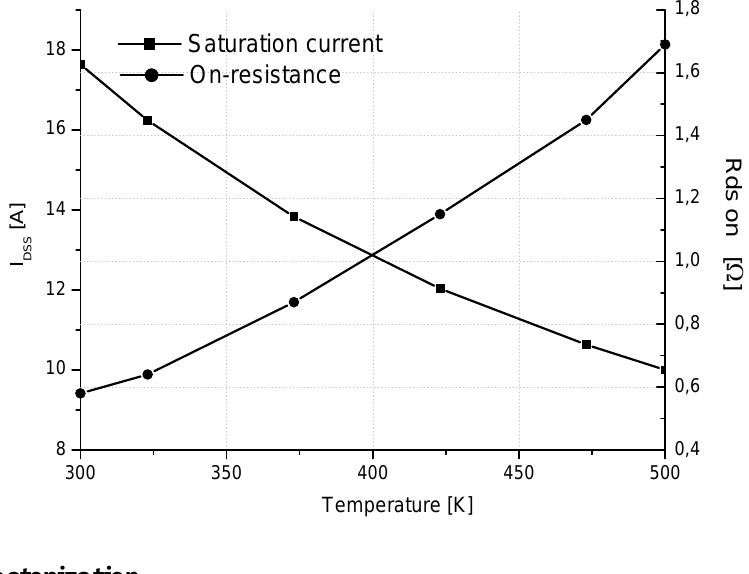
= 5 × 10 16 cm –3 DL